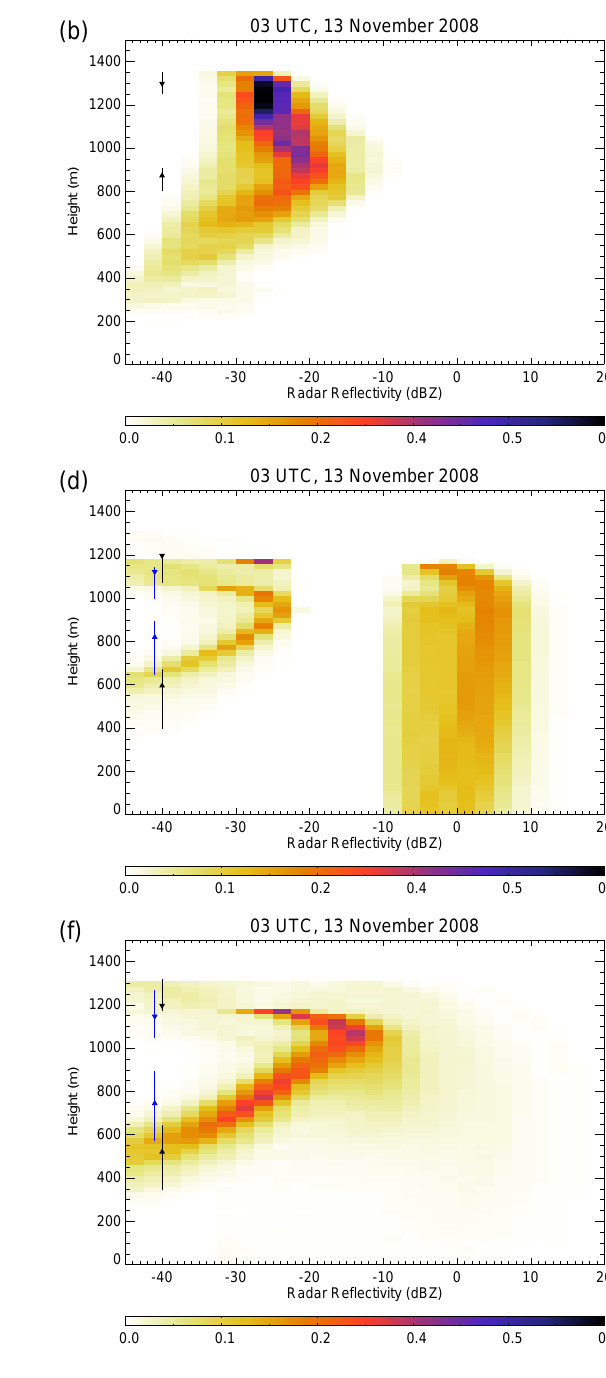
Fig. 6. Normalised histograms showing W-band radar reflectivity versus height from the Ron Brown for 30min either side of the time shown ( a and b ). MetUM histograms taken from a 1 ◦ box surrounding the Ron Brown at the time shown, for the 1km control ( c and d ) and modified microphysics ( e and f ) simulations. The green boxes represent estimated radar reflectivity from the BAe-146 in-situ measurements of the cloud and drizzle DSD, and the blue triangles the same estimate using only particles > 50µm. The black triangles and whiskers show the median and maximum/minimum cloud top height and base. For the model (c–f) , the black shows the range calculated using cloud fraction > 0 and blue shows the range calculated using cloud fraction > 0 : 5 .